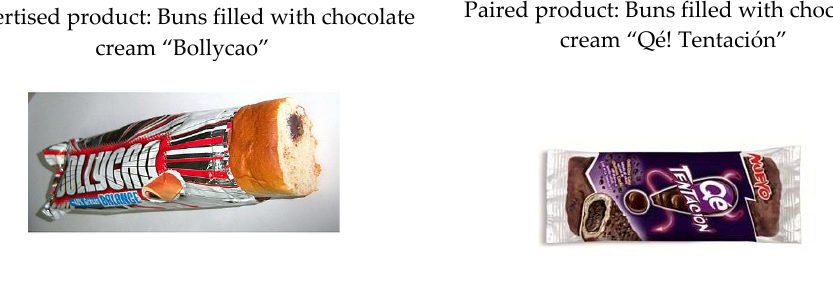
Figure 2. Images of the products used for the choice method.